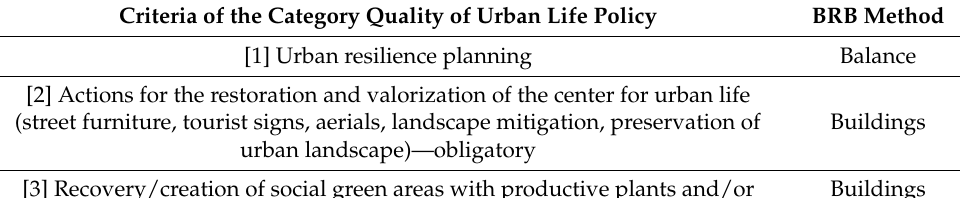
Table 5. The relationships between criteria Quality of Urban Life Policy and BRB